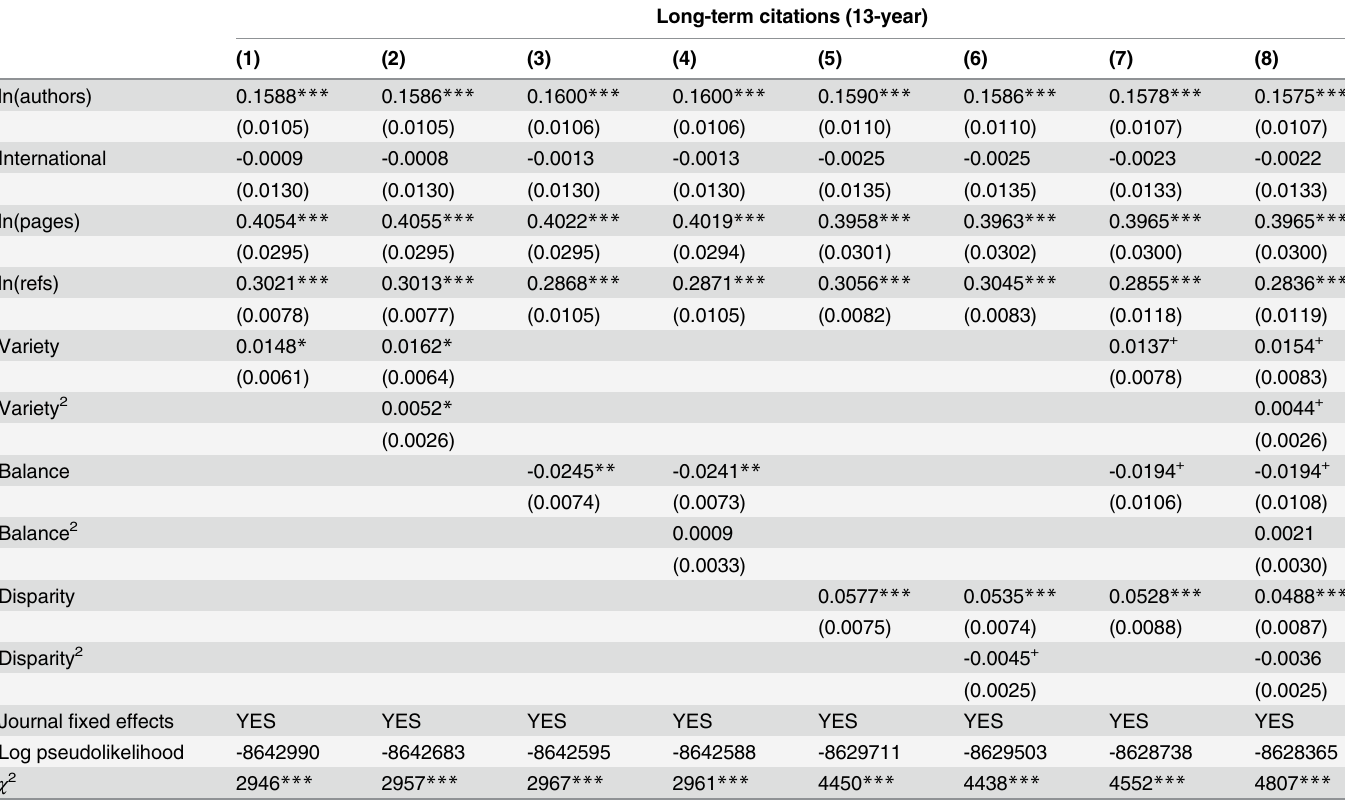
Table 5. Fixed Effects Poisson Models: Interdisciplinarity and Long-Term Impact ( N =